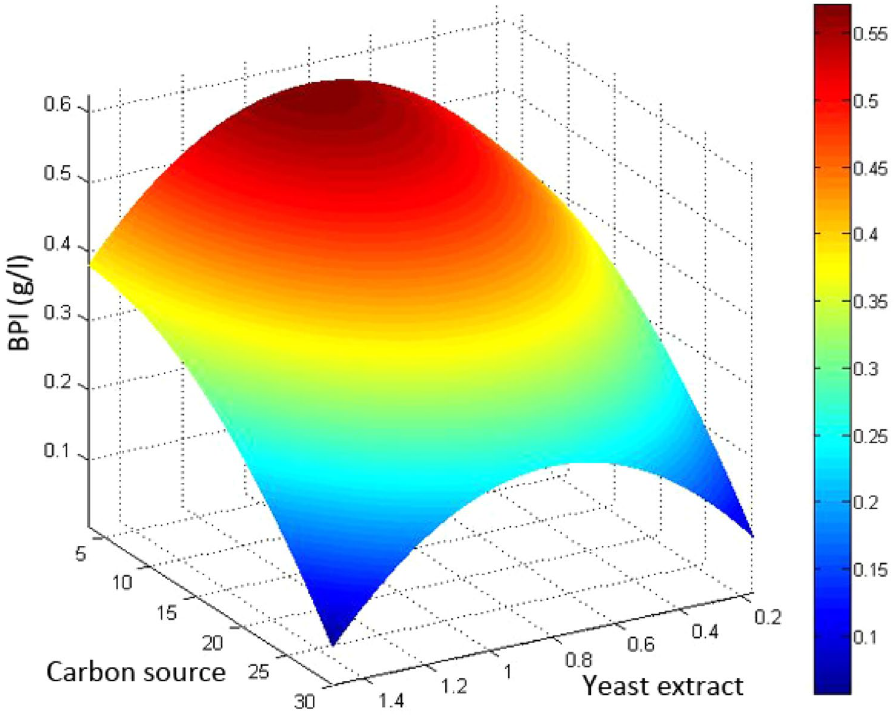
Fig. 6 Possible obtainable BPI in the media compatible with carbonate reservoir